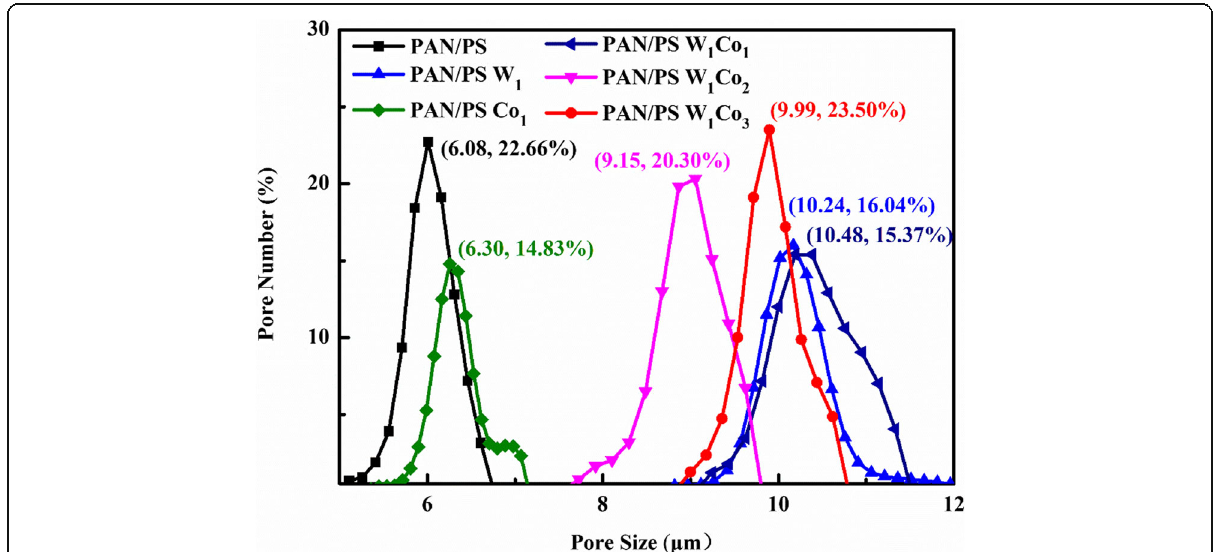
Fig. 7 Through-pore size distributions of micro-nanofibers membranes